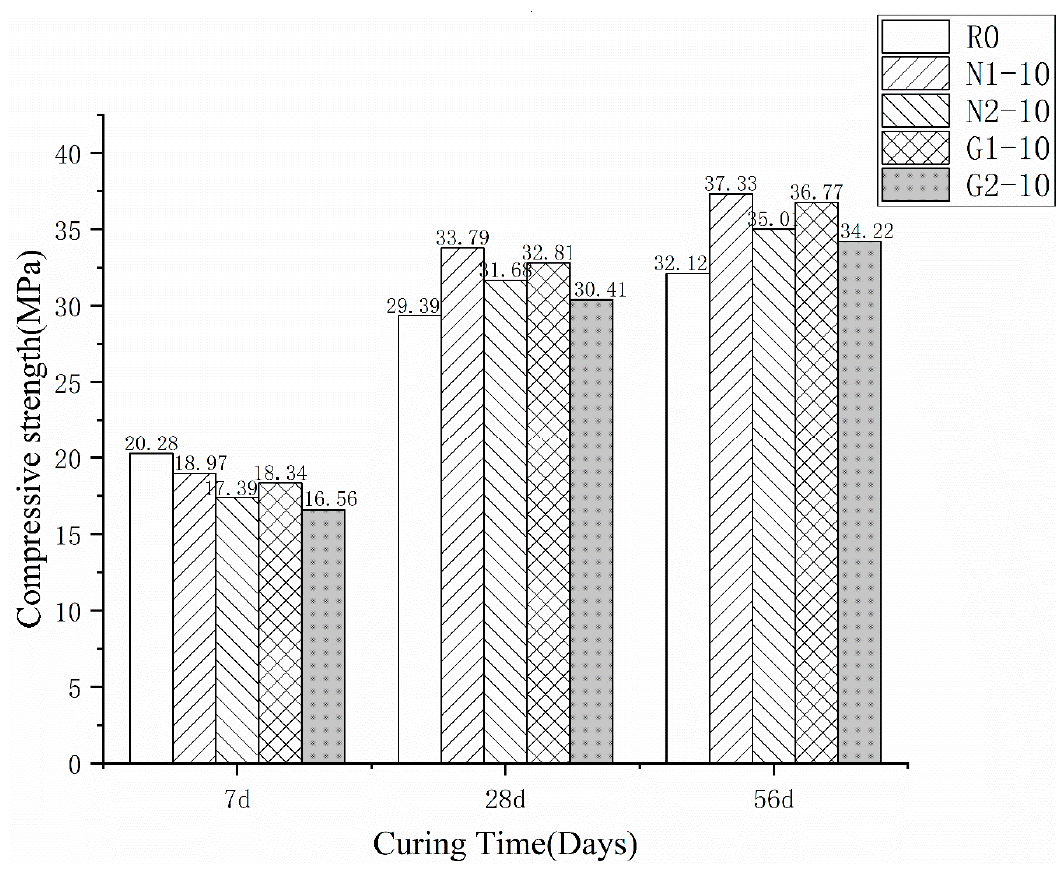
Figure 4. Compressive strength of different RHA cement at 7, 28, and 56 d.